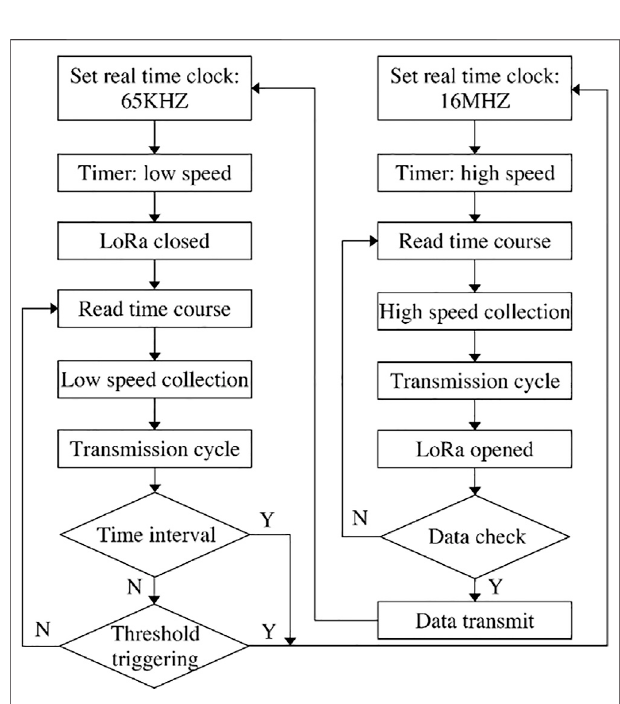
FIGURE 11 | Flow chart of low-power data collection.